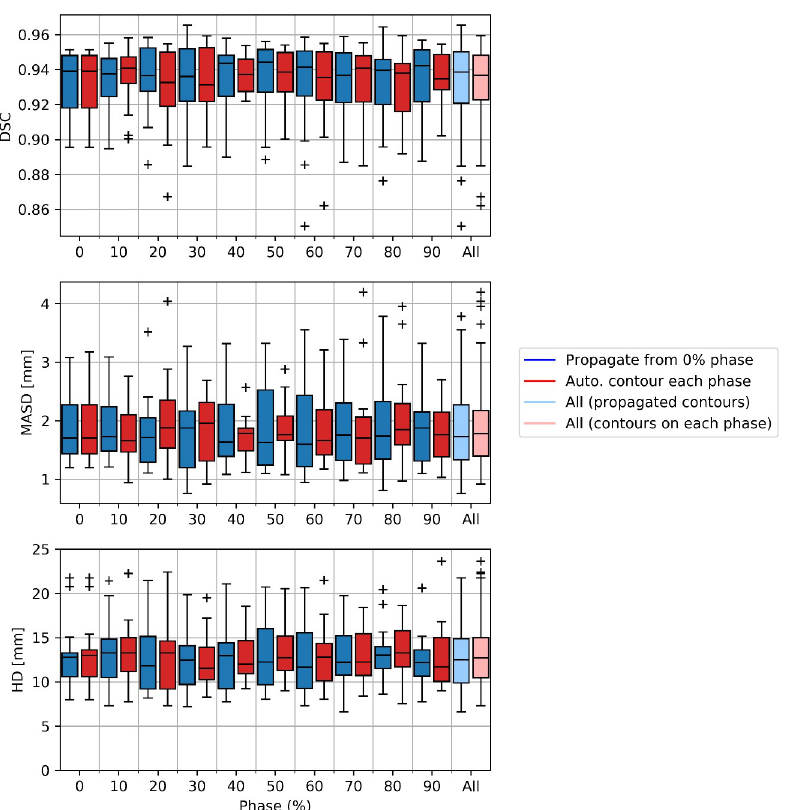
Fig 4. A comparison on automatic segmentation using our proposed method, propagation of delineations from the 0% phase using deformable image registration, compared to independent automatic segmentation for each individual phase. We use the Dice similarity coefficient (DSC), mean absolute surface-to-surface distance (MASD) and Hausdorff distance (HD) to compare the automatic segmentations derived using either method to the manual contouring. Results are presented as box plots aggregated over the patient cohort. Overall, both methods provide similar performance, with no statistically significant difference in delineation accuracy.